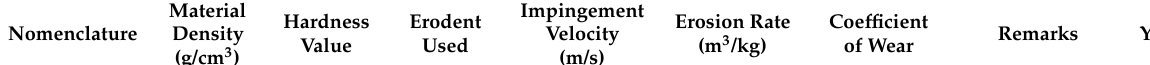
Table 1. Data on the erosion rates of neat thermoset and thermoplastic